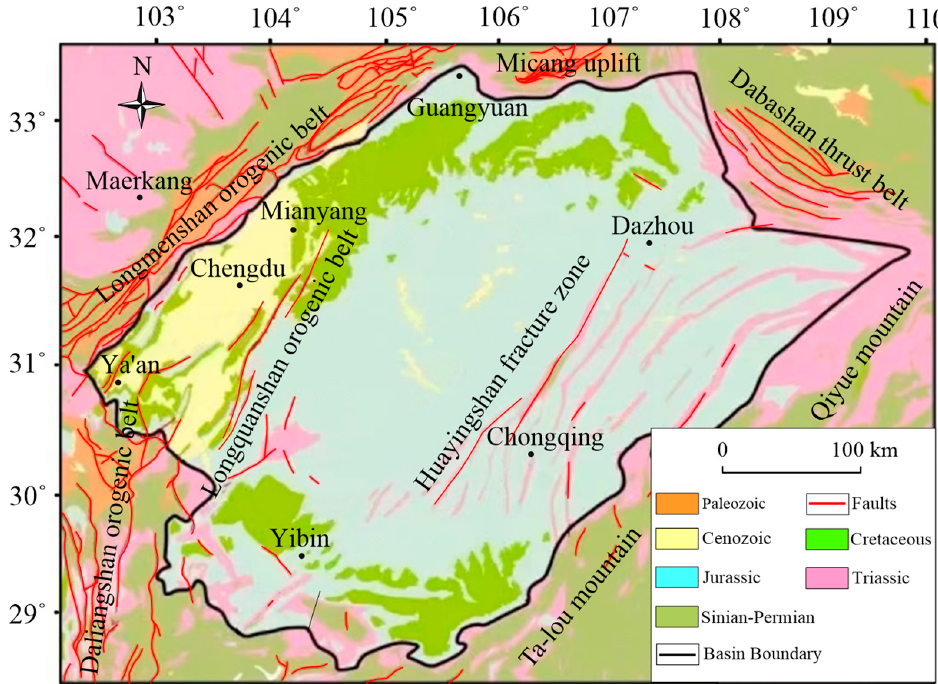
Figure 1. Regional geological map of the Sichuan Basin (modi fi ed from Zheng et al. [12]).